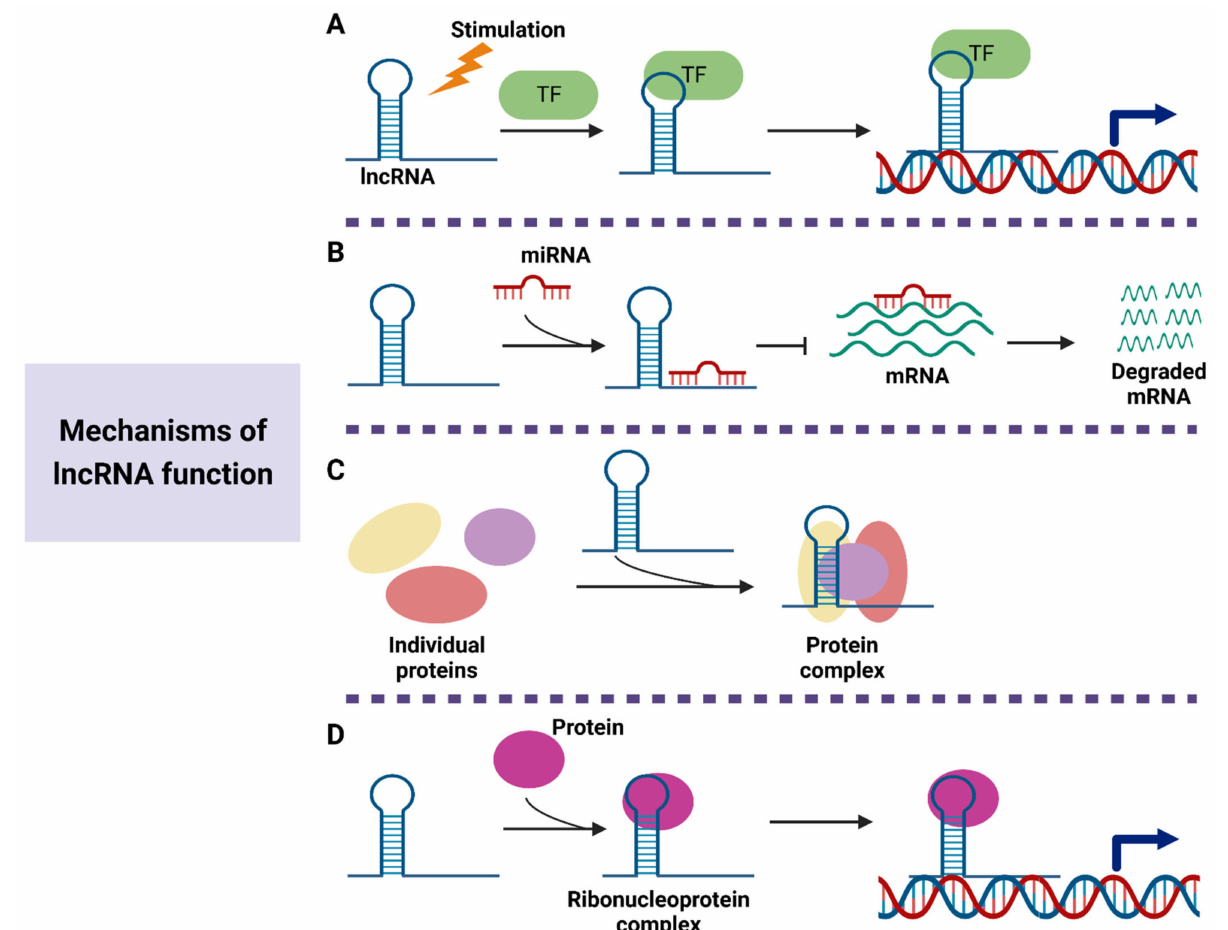
Figure 2. Functional mechanisms of lncRNAs. ( A ) Under several stimulation conditions, lncRNAs can combine with transcription factors to regulate signaling pathway. ( B ) LncRNAs prevent mRNA degradation by functioning as miRNA sponge. ( C ) LncRNAs can act as scaffolds to form protein complexes, thus regulating the transcription of the target genes. ( D ) LncRNAs modulate gene expression by guiding the ribonucleoprotein complex to the DNA